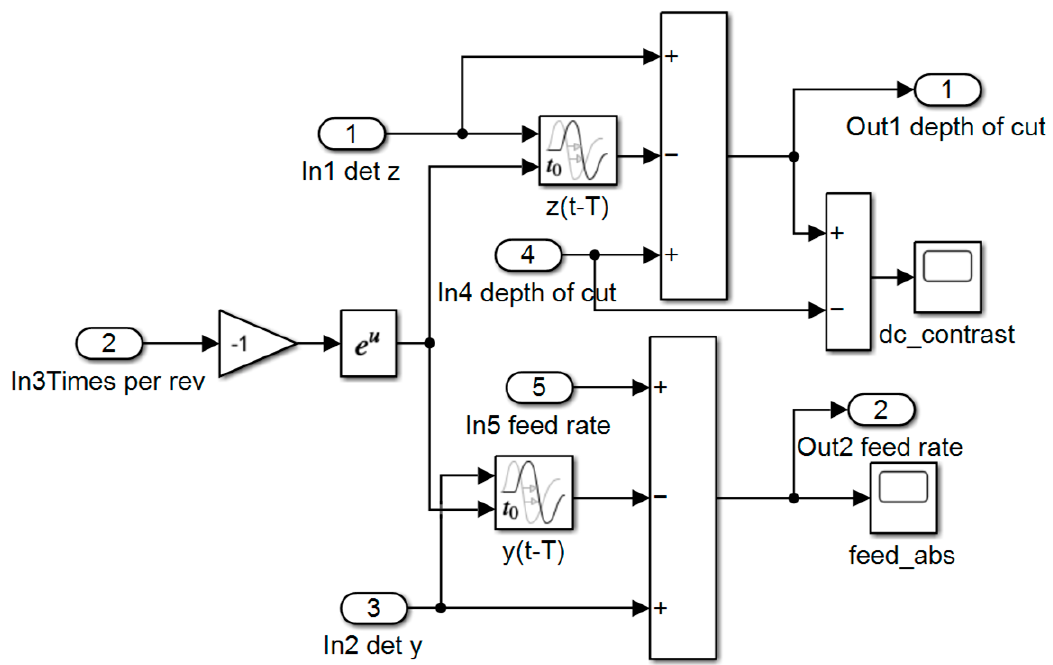
Figure 6. Simulink model of regenerative vibration.